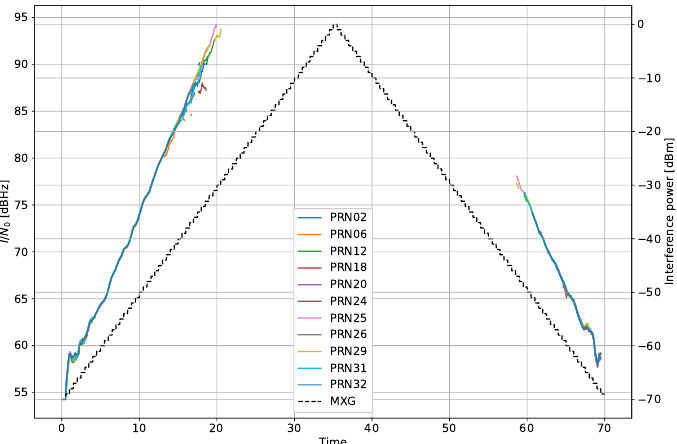
Figure 5. Estimated I / N 0 from the 4MHz bandwidth filtered noise interference